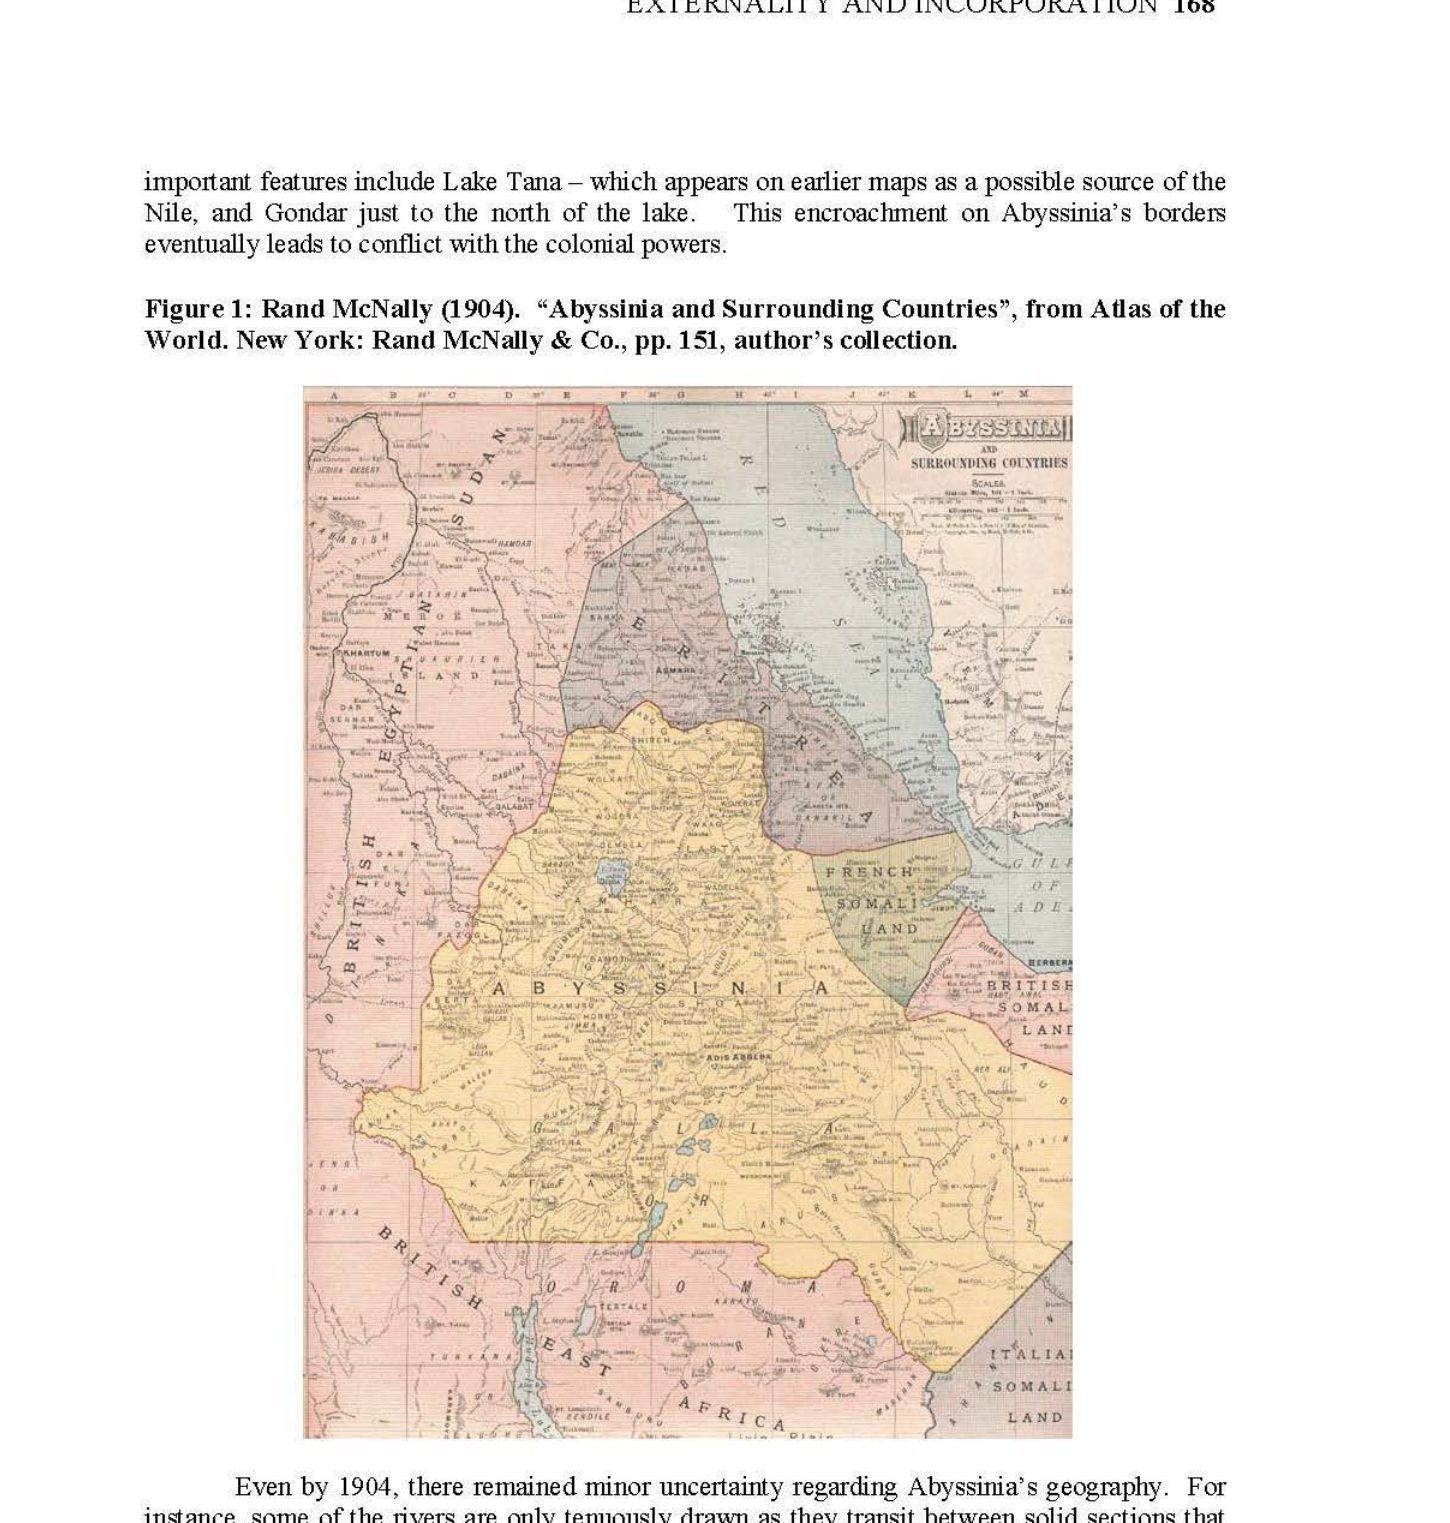
Figure 1: Rand McNally (1904). "Abyssinia and Surrounding Countries", from Atlas of the World. New York: Rand McNally & Co., pp.151, author's